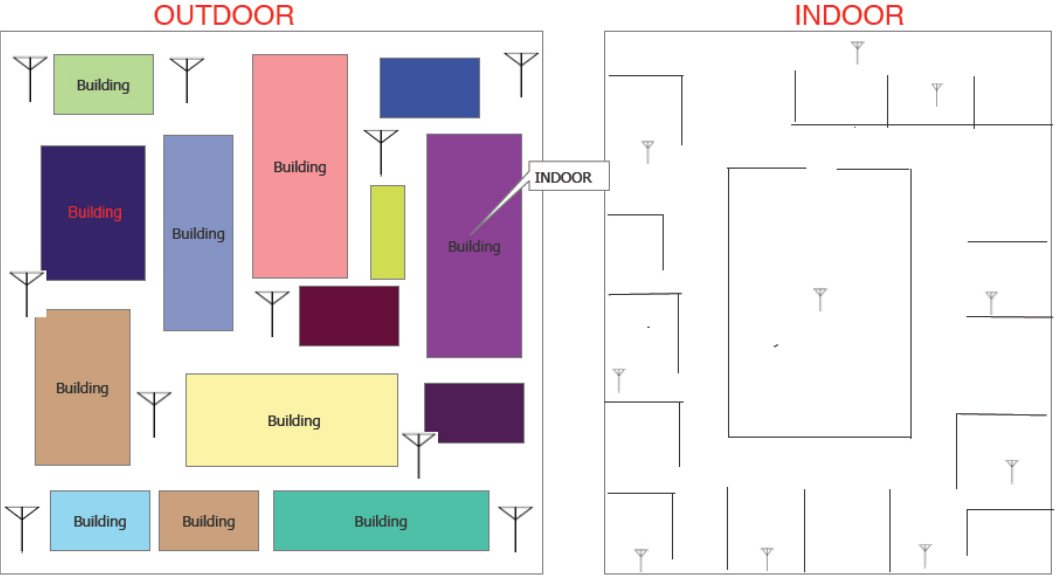
Figure 1. System model of Wireless indoor and outdoor microcells